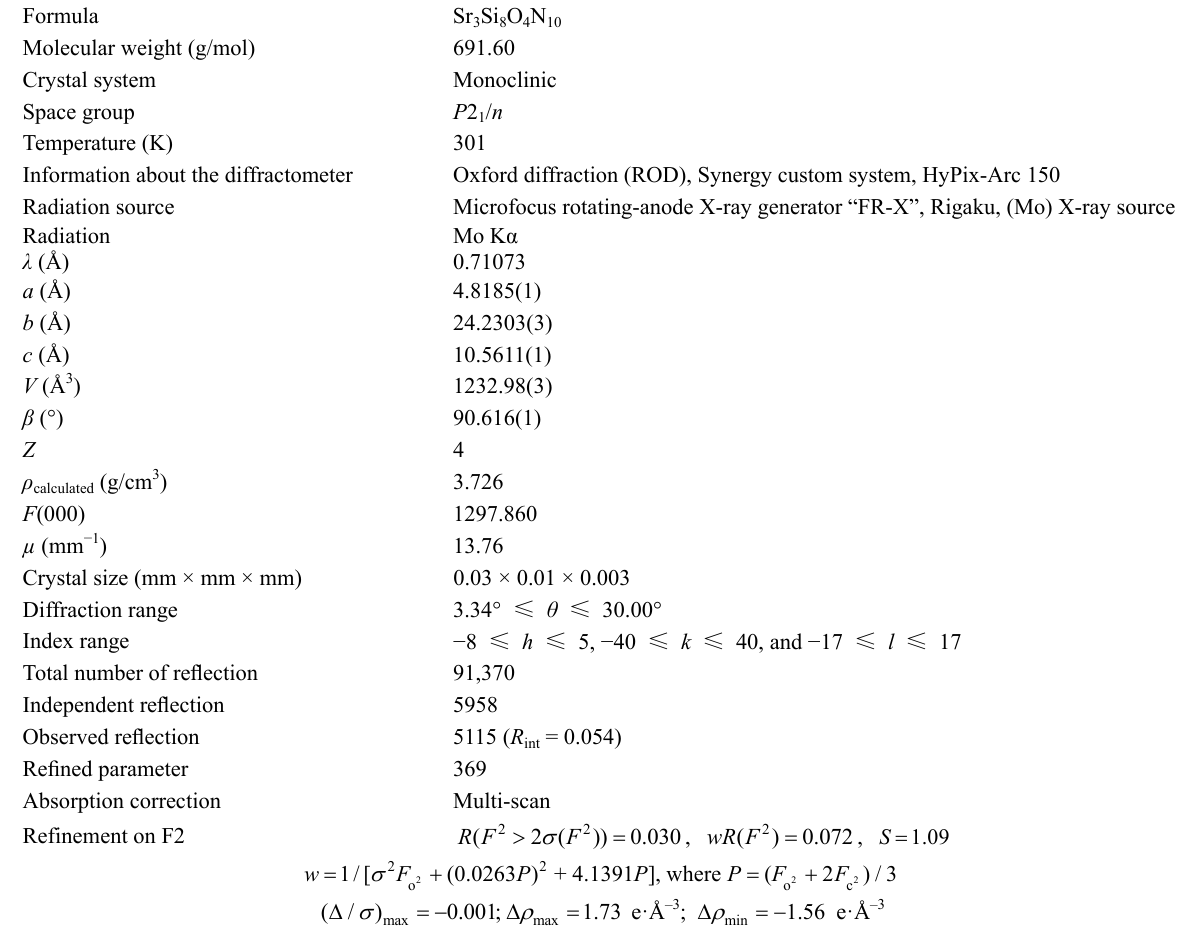
Fig. 3 (a) Single crystal pinpointed from fired powder mixture; (b) crystal structures of Sr 3 Si 8 O 4 N 10 projected along [100] and five different coordination environments for Sr; and (c) solid-state 29 Si NMR spectra of Sr 3 Si 8 O 4 N 10 . Table 1 Crystallographic data and structure re fi nement of Sr 3 Si 8 O 4 N